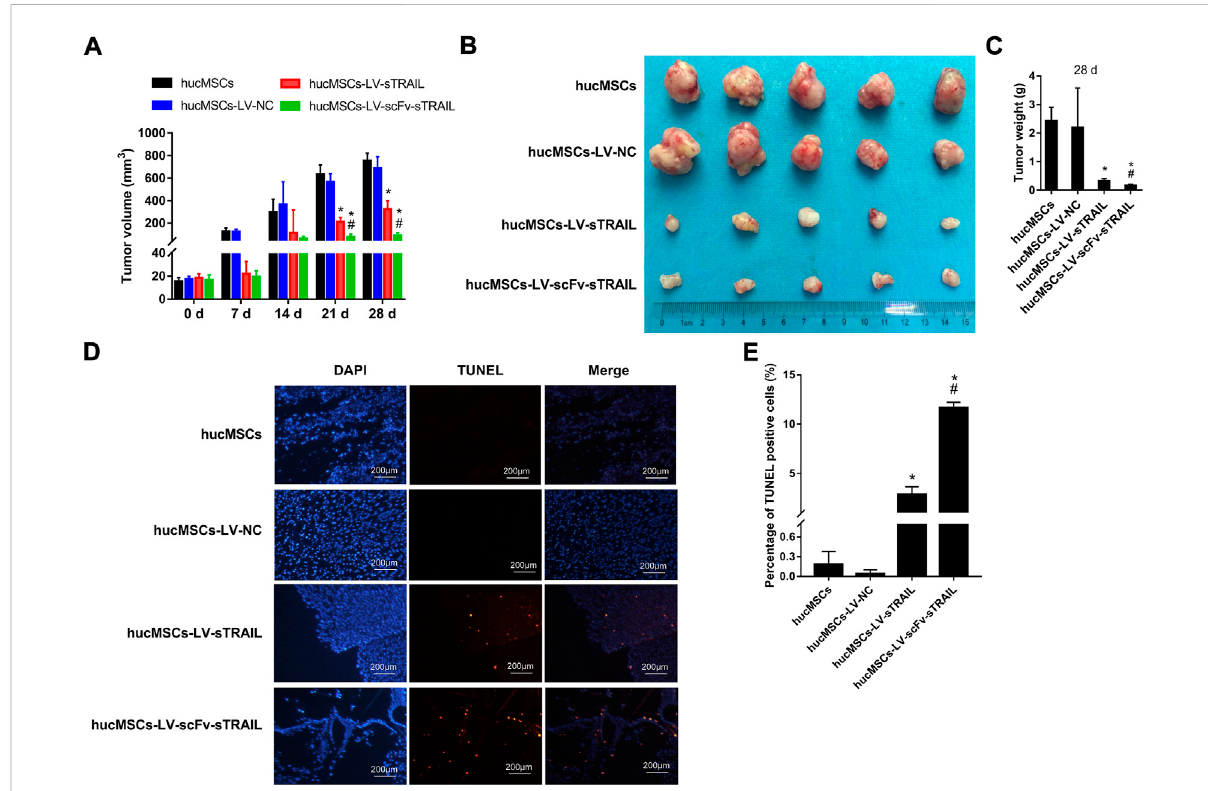
FIGURE 6 The effect of hucMSCs infected with LV-scFv-sTRAIL on glioma tumor growth. (A) Tumors volume. (B) The tumors isolated from mice. (C) Tumorsweighton28 days. (D) TherepresentativeimagesofapoptoticcellsinU87GxenografttumorsdetectedbyTUNELassay. (E)